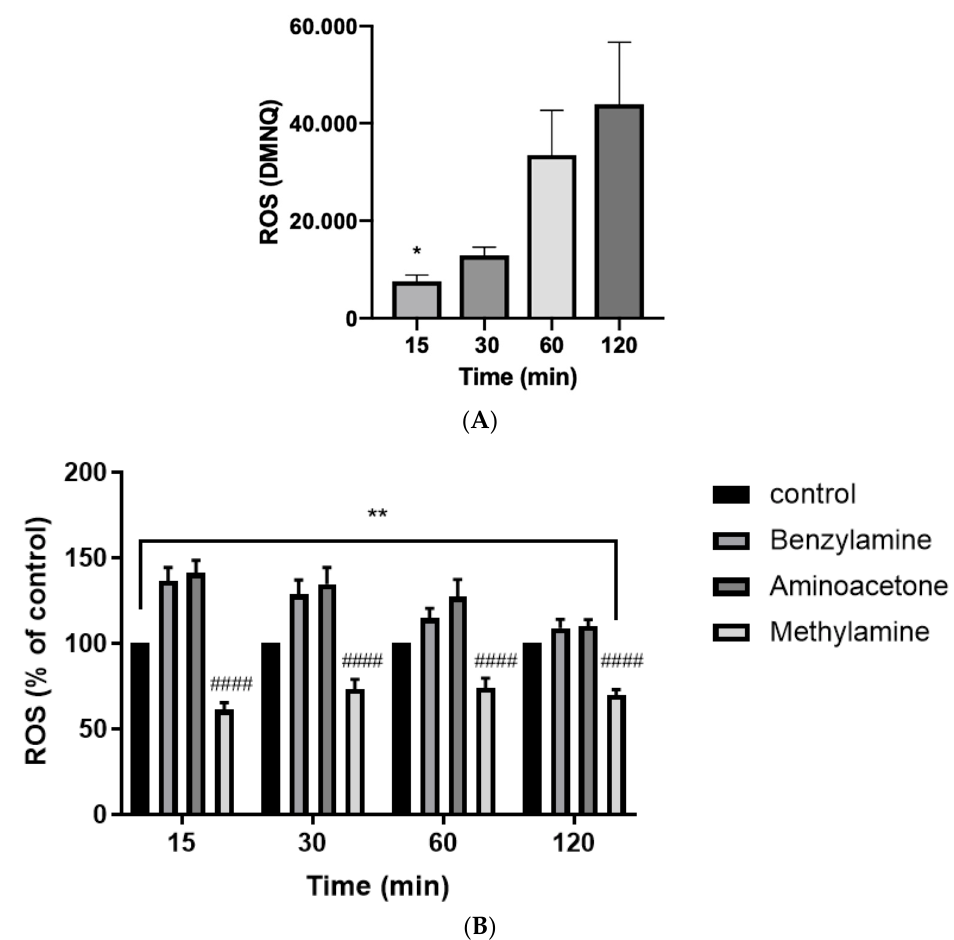
Figure 4. SSAO activity induces ROS formation in rat aortic VSMCs. In ( A ), VSMCs were treated with 5 µ M (20 µ L/well) DMNQ and ROS was measured over different time intervals. Significant difference in ROS production was detected over time (* p < 0.05 for 15 min vs. 120 min, one-way ANOVA followed by Tukey’s). In ( B ), ROS production (expressed as percentage of control) was compared over time (*) and after different amine treatments (#), benzylamine (500 µ M), aminoacetone (45 µ M) and methylamine (500 µ M). Significant difference in ROS formation was detected over time (** p < 0.01 for 15 min vs. 120 min, p < 0.01 for 30 min vs. 120 min, p > 0.05 for 60 min vs. 120 min, two-way ANOVA followed by Tukey’s). Multiple comparison (Tukey’s) then compared between different amine treatments. At 15 min incubation, #### p < 0.0001 for methylamine vs. benzylamine and #### p < 0.0001 for methylamine vs. aminoacetone. At 30-, 60-, and 120-min incubation #### p < 0.0001 for methylamine vs. benzylamine and #### p < 0.0001 for methylamine vs. aminoacetone The asterisk (*) indicates statistical significance in ROS production detected over time. The hash ( # ) indicates statistical difference in ROS production detected between treatments at each respective time point. Values are mean ± S.E.M. (n =